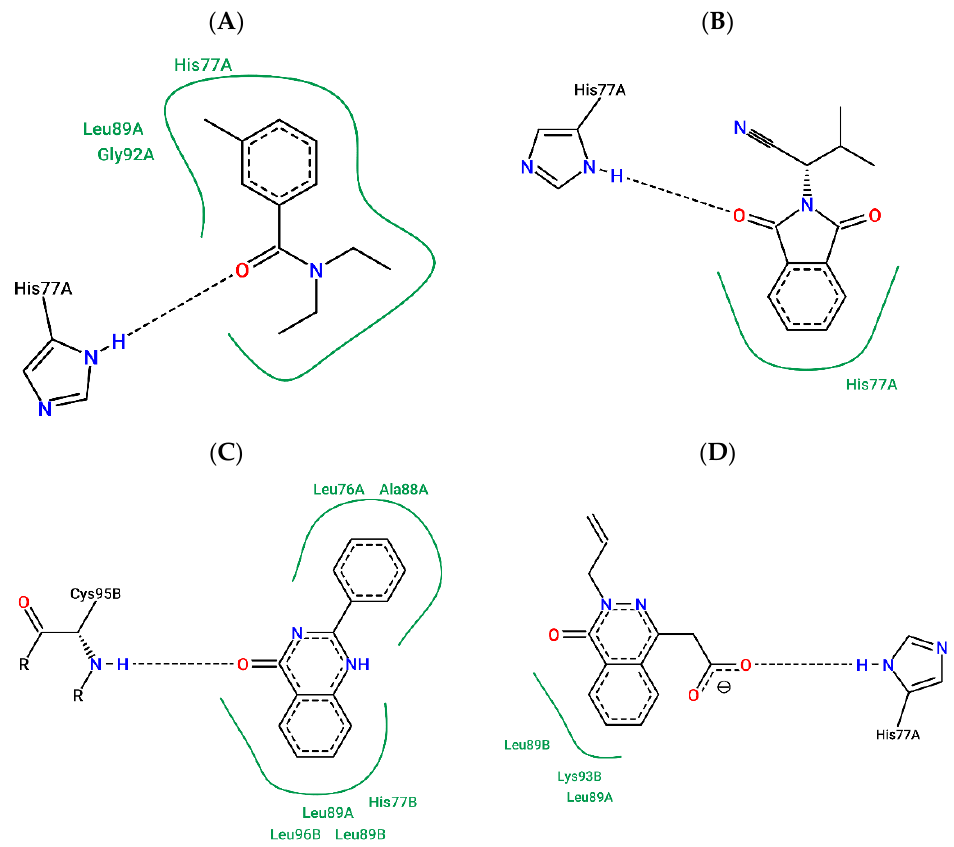
Figure 11. Interaction map of representative structures in MD of DEET ( A ), ZINC878 ( B ), ZINC305 ( C ) and ZINC141 ( D ) at the Aaeg OBP1 binding site generated by the Poseview server.